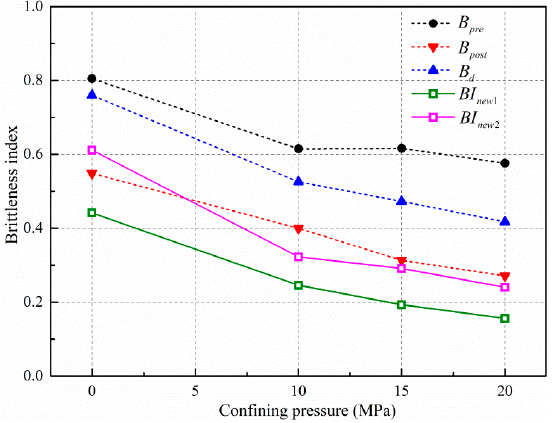
Figure 11. Relationships between confining pressure and brittleness indexes.